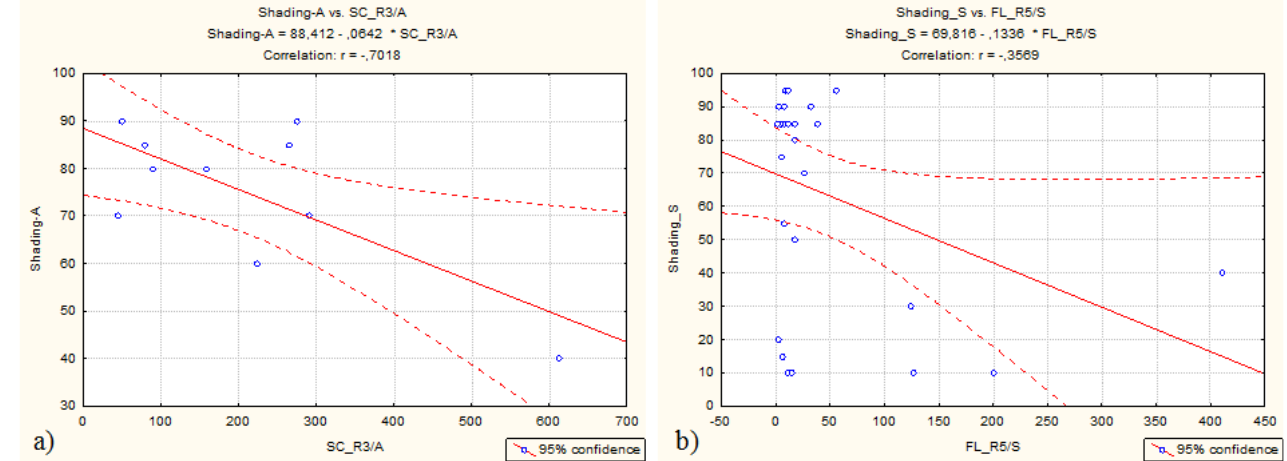
Figure 5. Scatterplots (Multiple linear regression) of the total number of individuals: ( a ) SC from R3 sites in relation to the % of shading during the autumn season (R 2 = 0.,5402; F = 4.11, p = 0.06); and ( b ) FL from R5 sites in relation to the degree of shading during the spring season (R 2 = 0.2045; F = 3.08, p = 0.06). Legend: A—autumn, S—spring.